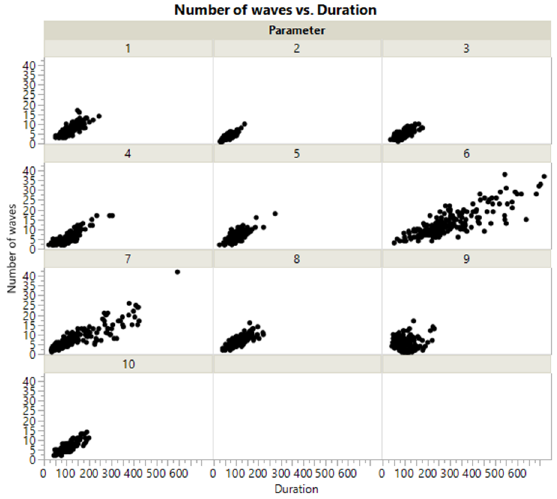
Figure 10. The relation between the number of waves vs. the duration of the epidemic per